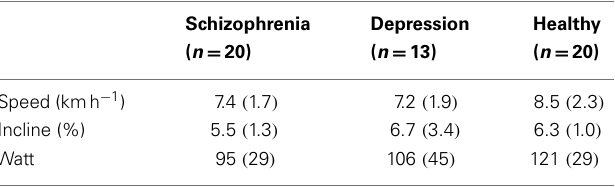
Table 2 | Mean (SD) work load of intervals during the high aerobic intensity training .